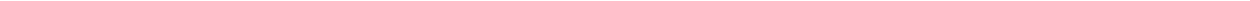
Fig. 6 The Nlrp3 R258W gut microbiota is shaped by IL-1 β -induced antimicrobial peptides. a , b Colonic LPMCs and epithelial cells (ECs) were isolated from WT and Nlrp3 R258W mice and assayed for the expression of the indicated genes via Q-PCR without stimulation. The data are shown as the means ± SEM. c , d Colonic LPMCs and ECs were isolated from naive ( c n = 3 for each genotype) or 4 days 4% DSS-treated ( d n = 4 for each genotype) WT, Nlrp3 − / − and Casp1/11 − / − mice, the cells were treated with BAC (MOI = 20:1) ± ATP, and the culture media was assayed for IL-1 β and IL-18 secretion via ELISA. The data are shown as the means ± SEM. * P < 0.05, ** P < 0.01, *** P < 0.001 (one-way ANOVA with Tukey ’ s post-hoc test). e Changes in body weight in WT ( n = 8), Il1r1 − / − ( n = 9), Nlrp3 R258W x IL1r1 − / − ( n = 6), and Nlrp3 R258W ( n = 5) mice during DSS-induced colitis. The data are shown as the means ± SEM, * P < 0.05, ** P < 0.01 (one-way ANOVA with Tukey ’ s post-hoc test). f The microbiota WT-index was also calculated for mice in e before DSS treatment. The medians with interquartile ranges are shown. * P < 0.05, ** P < 0.01 (Kruskal – Wallis test). g Untreated WT ( n = 4) and Nlrp3 R258W ( n = 2) mice colon tissue RNA was assayed by RNAseq analysis, selected AMPs were shown to be upregulated in the Nlrp3 R258W colon at varied extent. * P < 0.05, ** P < 0.01 (statistical comparison was conducted using DESeq2, see “ Methods ” section). h AMPs expression in untreated colon tissue from WT, Nlrp3 R258W